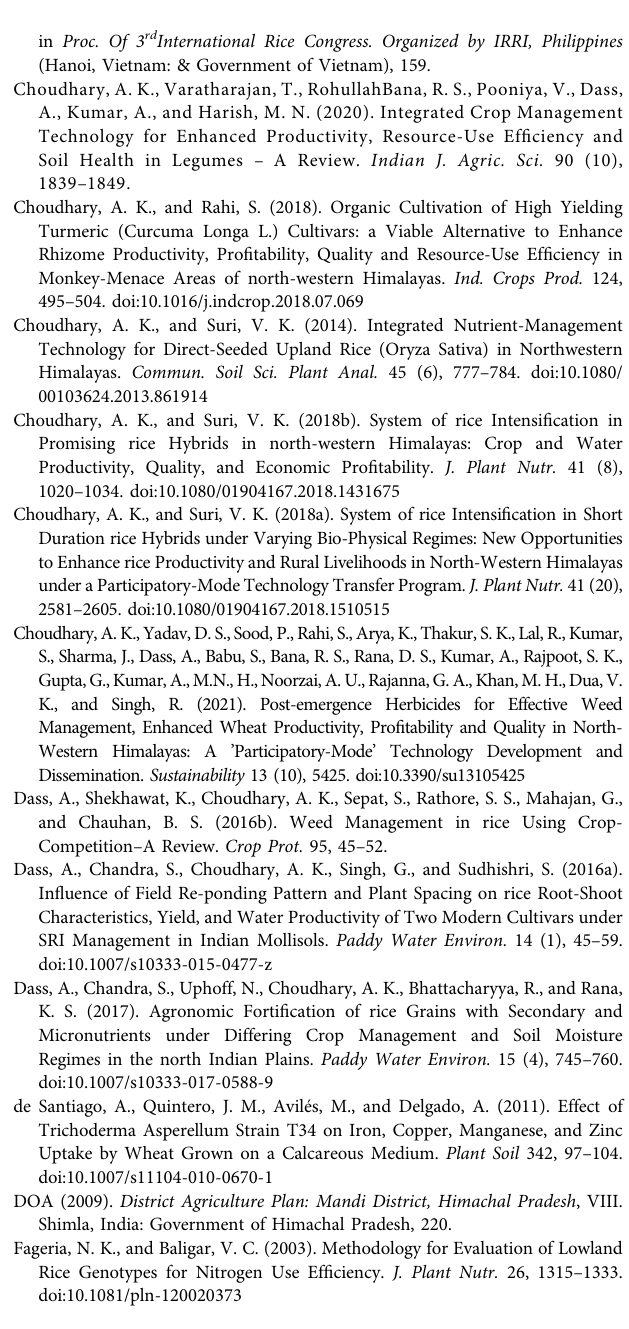
Supplementary Figure S1 | Rice cultivation under SRI in NW Himalayan state, Himachal Pradesh, India. SupplementaryFigureS2| Monthlyrainfallandmeantemperatureduringricecrop growing seasons (2010 – 2013) [source: Agro-meteorological Observatory, CSKHPKV, Farm Science Centre, Sundernagar,